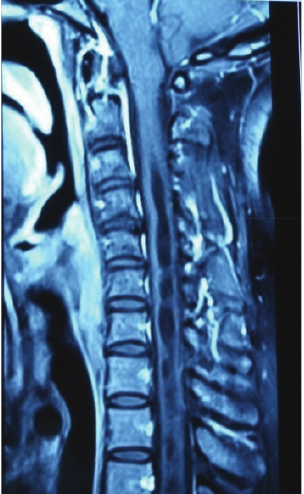
Figure 4: T2-weighted sagittal magnetic resonance imaging (MRI) of the cervical spine revealed a syrinx throughout the cervical cord, with extension into the upper thoracic region with mild diffuse volume